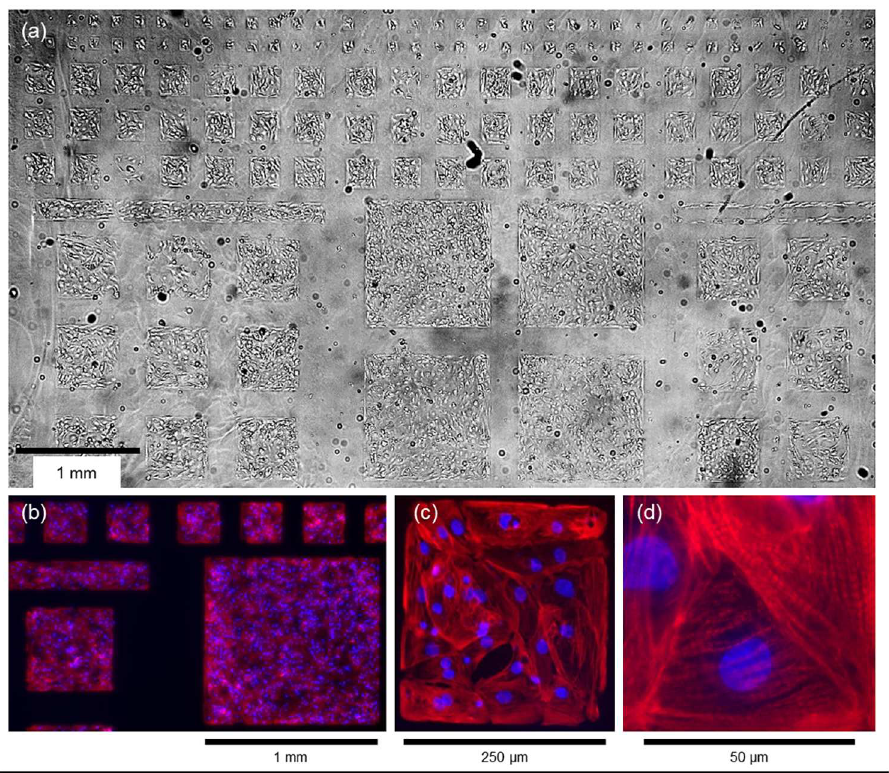
Fig 1. Patterned cardiomyocytes. Cardiomyocytes were patterned on a cytophobic polyacrylamide surface patterned with covalently bound fibronectin by micro-contact printing. a) Trans-illumination image of patterned cardiomyocytes showing the full 6 mm field of view. b) Fluorescence images of cardiomyocytes on patterned islands with nuclear stain DAPI (blue) and myofibril stain cardiac troponin T (red). c) A magnified view of one 250 μ m island. d) Myofibril banding is clearly visible at single-cell